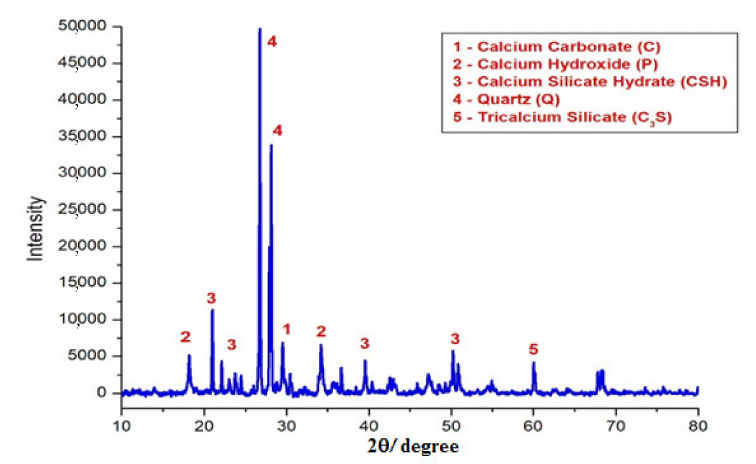
Figure 17. XRD pattern of LSF